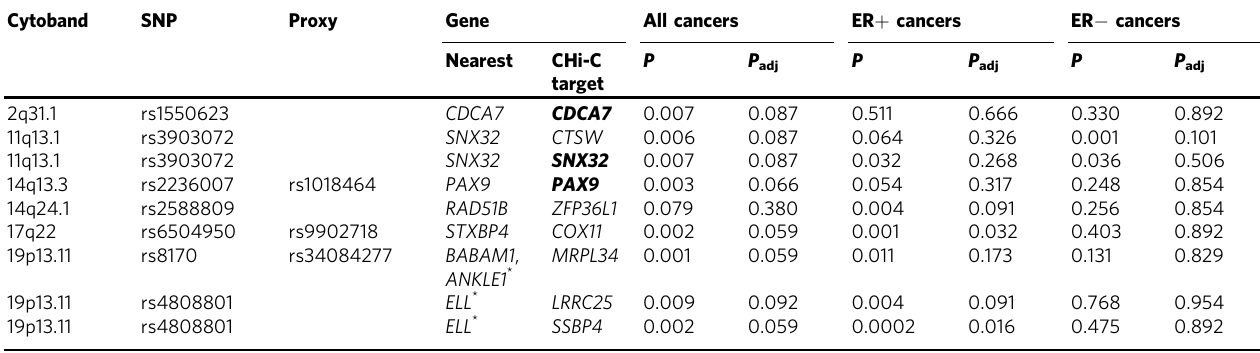
Table 3 Nine CHi-C putative target genes that were statistically signi fi cant eQTLs (FDR adjusted P < 0.1)